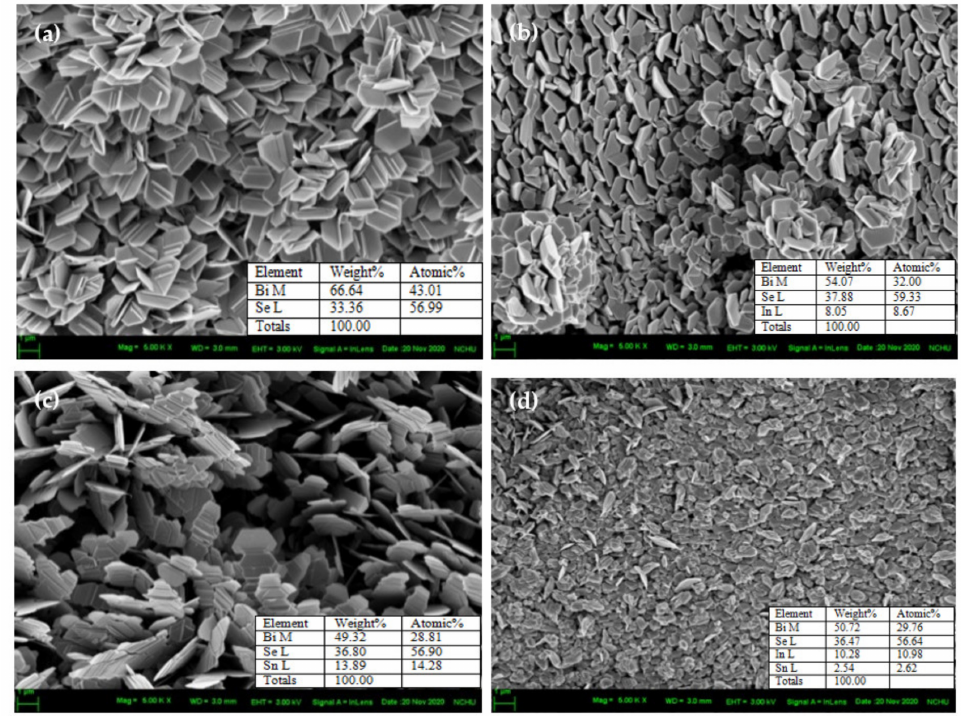
Figure 2. FESEM images and EDS results of ( a ) pristine, ( b ) In-, ( c ) Sn-, and ( d ) (In, Sn)-doped Bi 2 Se 3 nanoplatelets. Table 2. Average diameter, average thickness, and FESEM–EDS of Bi, Se, In, and Sn (atomic percent, at.%) of pristine, and In-, Sn-, and (In, Sn)-doped Bi 2 Se 3 nanoplatelets.